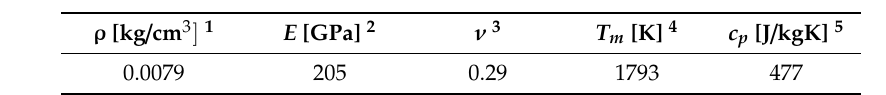
Table 2. Chemical composition of annealed and pickled AISI 301 (mas %). Data from [19]. C